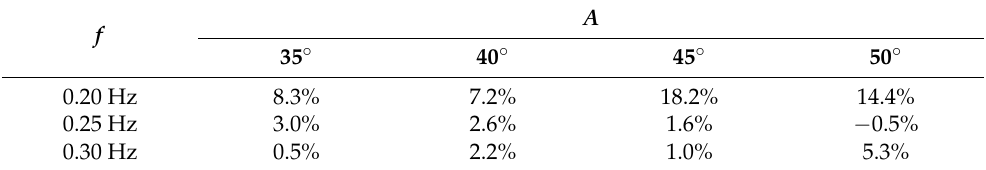
Table 5. Mean thrust comparison of sinusoidal-based mode to conventional nondeformable mode.